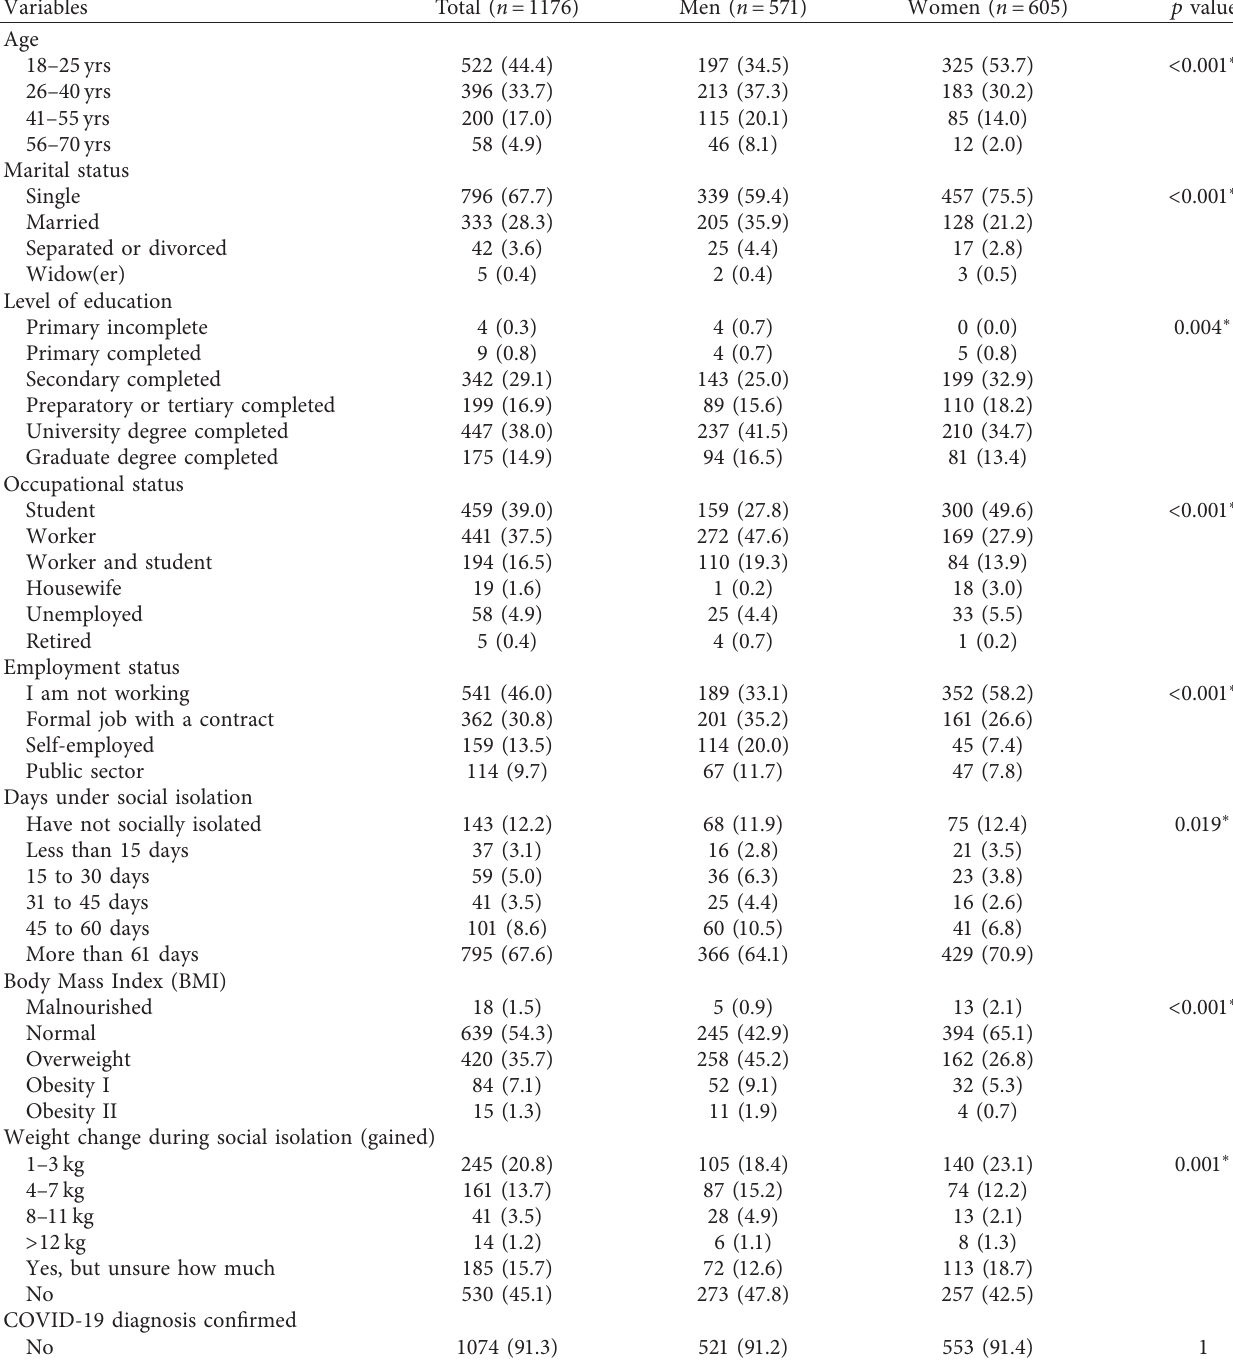
Table 1: Sociodemographic and anthropometric